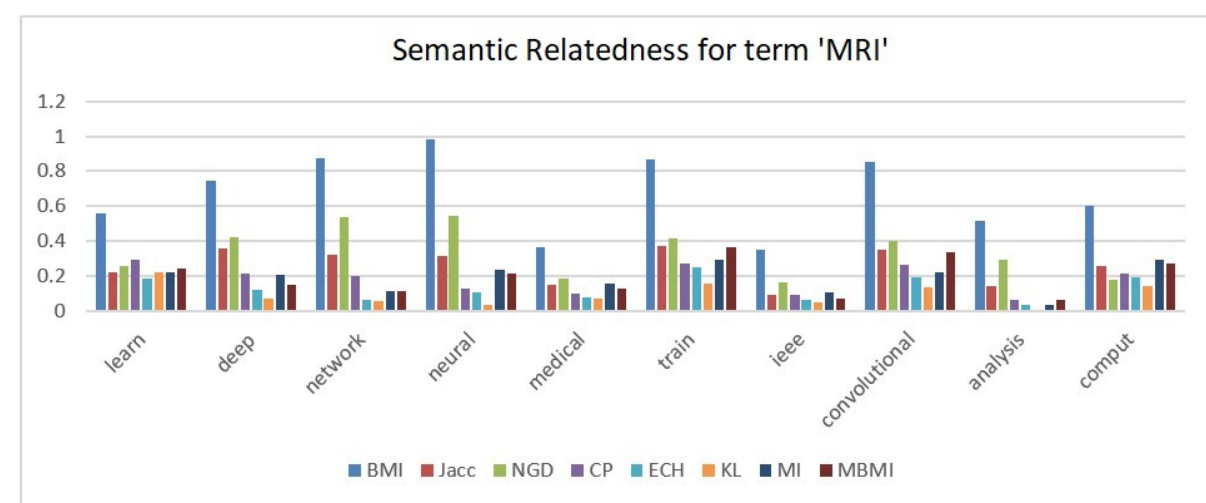
Figure 6. Semantic Similarity of term “MRI” with terms using different